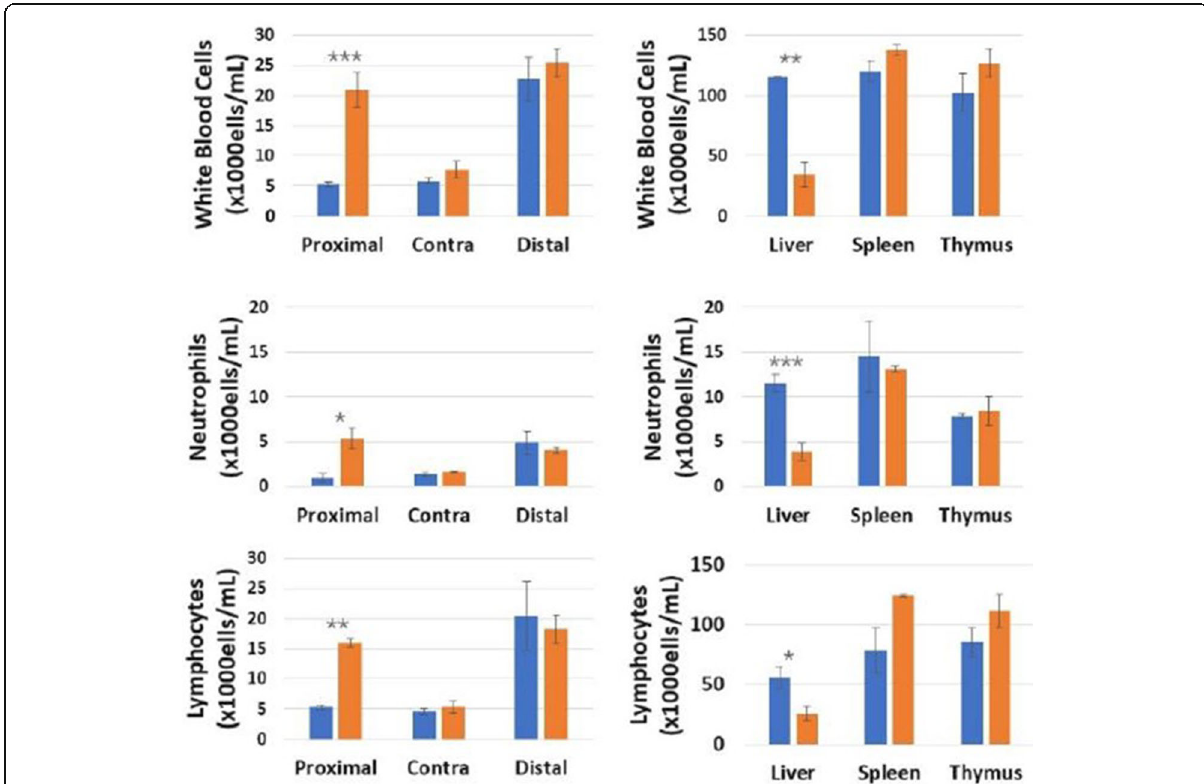
Fig. 4 White blood cell, neutrophil and lymphocyte concentrations in the directly stimulated popliteal lymph node, contralateral popliteal lymph node, distal axillary lymph node, spleen liver, and lymphatic duct/lymphatic fluid with and without (sham CTRL) an ultrasound-induced nerve stimulation directly above the popliteal lymph node. N =6. One way ANOVA with multiple comparison analysis *= p ≤ 0.05, **= p ≤ 0.005,***= p ≤ 0.0005; Ultrasound stimulation parameters: 1.1MHz, 136.36 μ s pulse length, and 0.5ms pulse repetition period, applied pressure of 0.83MPa as previously reported